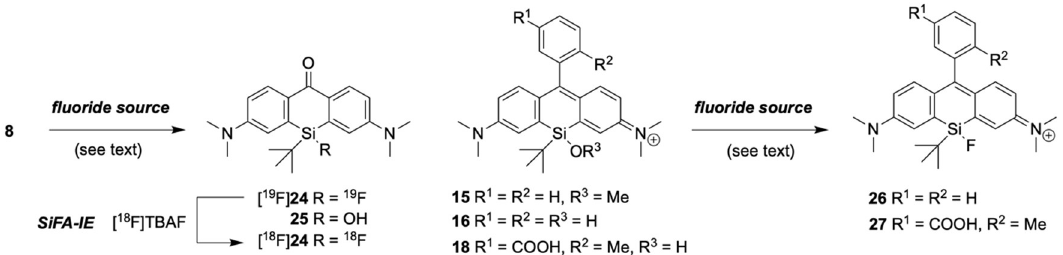
Figure 5. By using different nucleophilic fluoride sources (see text), it was possible to convert model compound 8 into the corresponding silyl fluoride 24 , which underwent SiFA-IE. The fluorination of SiR 16 to 26 was accomplished on a small scale and monitored by 19 F-NMR, but 26 underwent rapid hydrolysis under aqueous conditions.